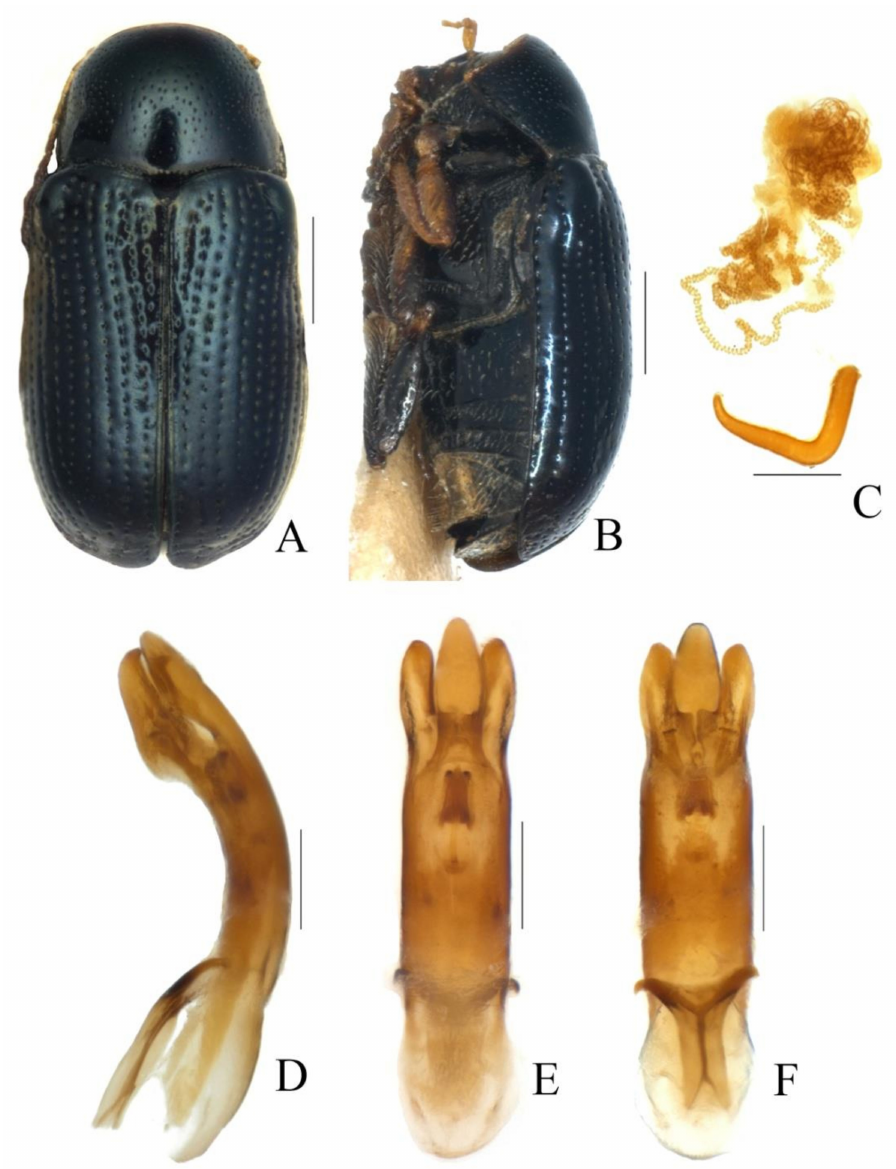
Figure 13. Cryptocephalus ( Burlinius ) confusus Suffrian, 1854: ( A ) habitus; ( B ) lateral view of habitus; ( C ) spermatheca; ( D ) lateral view of aedeagus; ( E ) dorsal view of aedeagus; ( F ) ventral view of aedeagus. (Scale bars: ( A , B ) = 0.5 mm, ( C – F ) = 0.2 mm) (( A – C ): female; ( D – F ): male; both from Hebei.) Synonym: Cryptocephalus discretus Baly, 1873: 97 (type locality: Chusan, Tsushima, Japan, type deposited: BMNH); Marseul, 1875: 189; Kraatz, 1879: 265 (Amur); Clavareau, 1913: 146 (catalogue); Chûj ô , 1942: 53 (Kwantung); Chen, 1942: 118 (Suiyuan, Hupeh); Gressitt and Kimoto, 1961: 149 (Kiangsu, Kirin, Korea) [6,7,20,21,23–25]. Cryptocephalus rectipennis Jacoby, 1890: 87 (type locality: Changyang; type de- posited: MCZ); Clavareau, 1913: 180 (catalogue); Chen, 1942: 118 (as synonym of Cryptocephalus discretus )